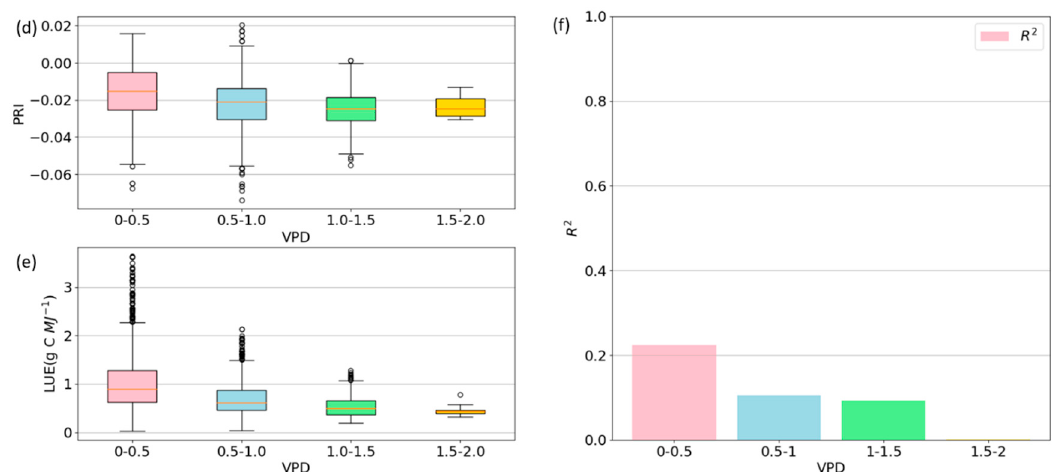
Figure 7. The half-hour time scale of PRI and LUE are as affected by Ta and VPD ( a , b , d , e ). Correlation between PRI and LUE under different temperatures and VPD gradings ( c , f ).